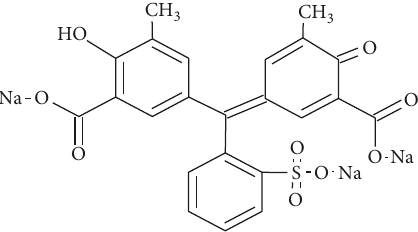
Figure 1: The chemical structure of eriochrome cyanine R (ECR).